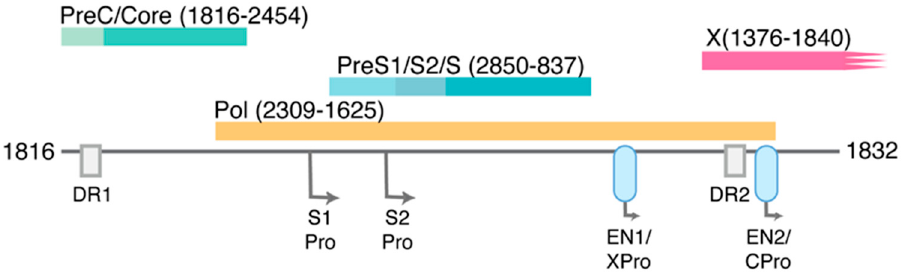
Figure 3. ORFs of HBV dslDNA form. As with Figure 1, coloured blocks represent each of the four main open reading frames. Associated promoters (Pro), enhancers (EN1 and EN2, light blue ovals), and direct repeat regions (DR1 and DR2) are also depicted. The approximate nts of the 5’ and 3’ ends are shown (numbering based on HBV DNA sequence from Genbank Accession #AB241115). As a result of the dslDNA forms generated by in situ priming (Figure 2b), the X ORF is truncated at its C-terminus (by at least three amino acids) and the pre-core/core promoter is separated from its ORF. dslDNA (like rcDNA) can be transported to the nucleus to form cccDNA (containing a redundant 16 nt insertion) or be released as virions containing dslDNA [35]. The cccDNA produced from dslDNA contains insertions that are not supportive of rcDNA synthesis, but can make up a large fraction of the cccDNA pool (up to 20% in the woodchuck hepatitis B virus model), and some forms may generate progeny dslDNA [35–37]. Further, dslDNA-derived cccDNA can revert back into wild-type cccDNA, possibly via homologous recombination